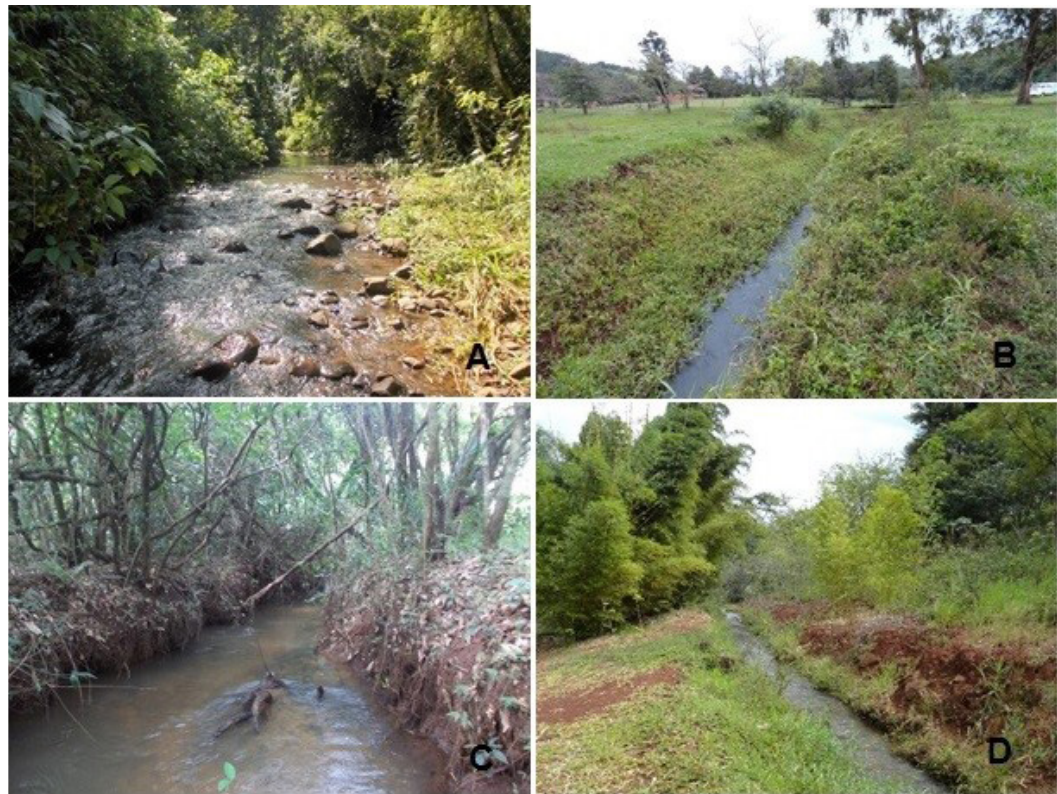
Figure 1. General view of the four study sites, two in Itaúna stream (A- with and B- without riparian vegetation) and two in Farias stream (C- with and B- without riparian vegetation).